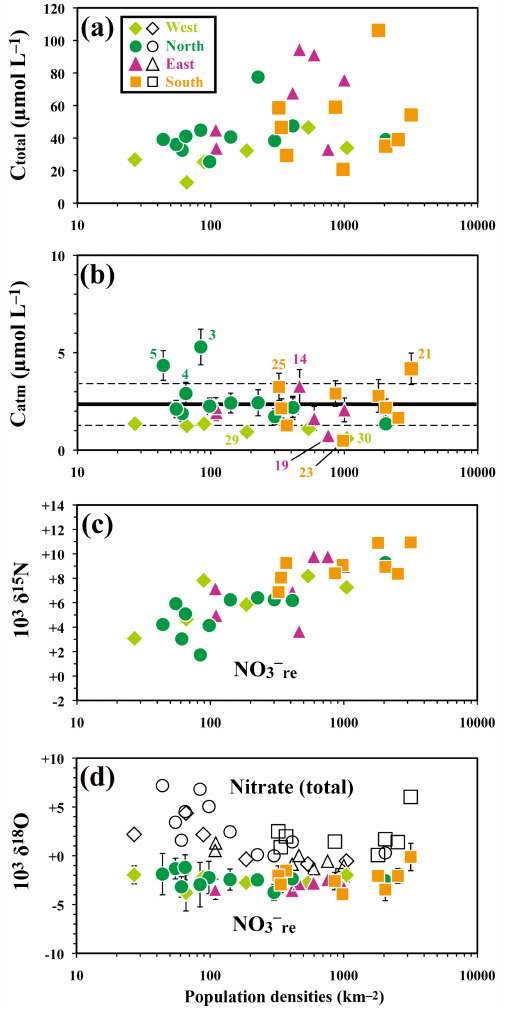
Figure 7. Annual average concentration of (a) nitrate ( C total ) and (b) NO − (atm) ( C atm ) in each inflow stream plotted as a function 3 of the population density in each catchment, together with (c) the annual average value of δ 15 N and (d) that of δ 18 O for remineralised NO − (NO − (re)). The annual average δ 18 O values of nitrate (total) 3 3 are also presented in (d) . The symbols represent the location of each river (west: diamonds; north: circles; east: triangles; south: squares). The errors larger than the sizes of the symbols are presented by error bars. Some of the streams in (b) are indicated by